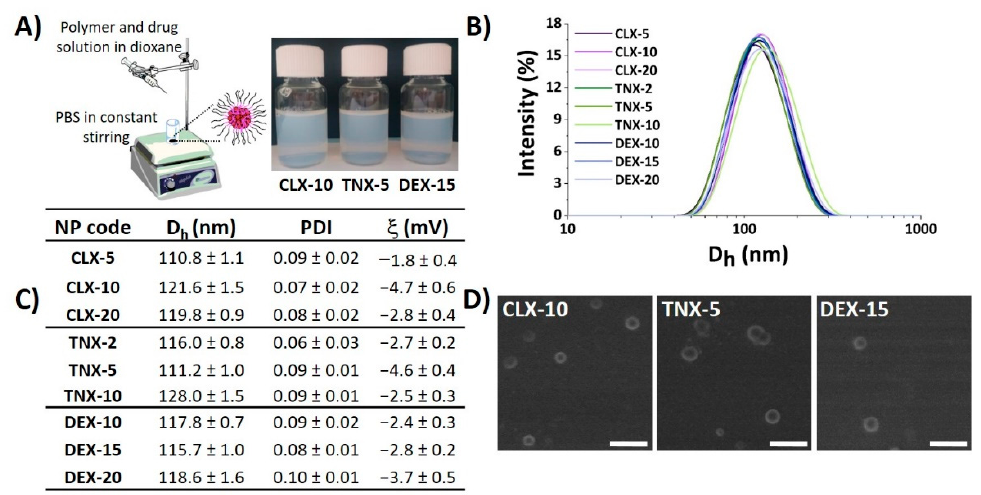
Figure 1. Physicochemical properties of CLX, TNX and DEX-loaded NPs. ( A ) NP suspensions obtained by the nanoprecipitation method. Image created using ChemDraw. ( B ) NP size distribution immediately after synthesis. ( C ) Hydrodynamic diameter (D h ), polydispersity index (PDI) and zeta potential ( ξ ) values of NPs. ( D ) SEM micrographs of CLX-10, TNX-5 and DEX-15 NPs. Scale bar: 300 nm.